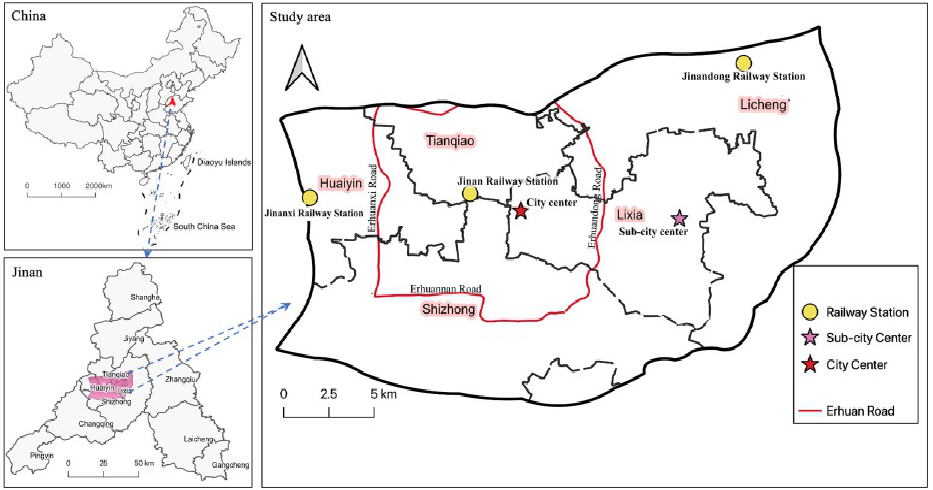
Figure 1. Map of Study area in